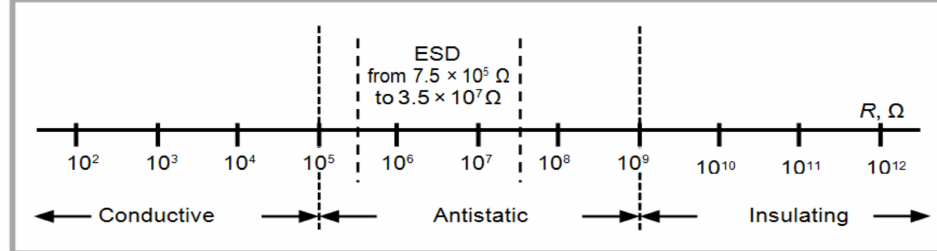
Figure 3. The scale of the electric properties of materials